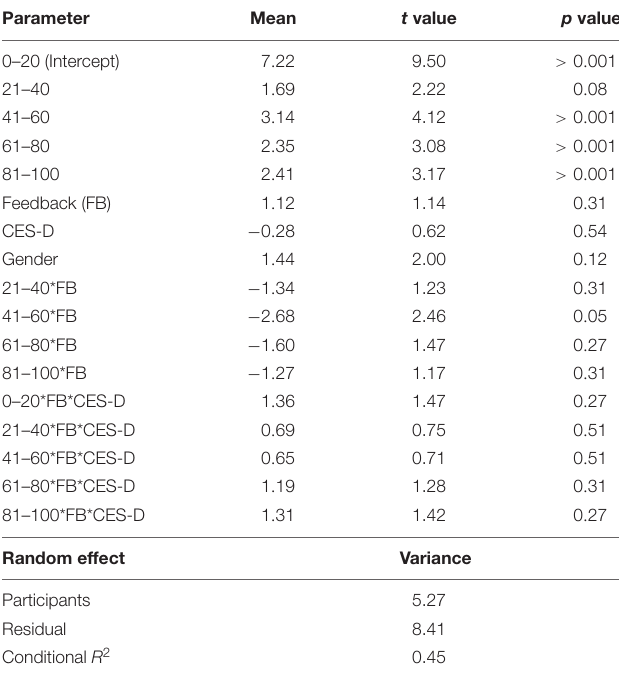
TABLE 3 | Estimated parameters using the regression